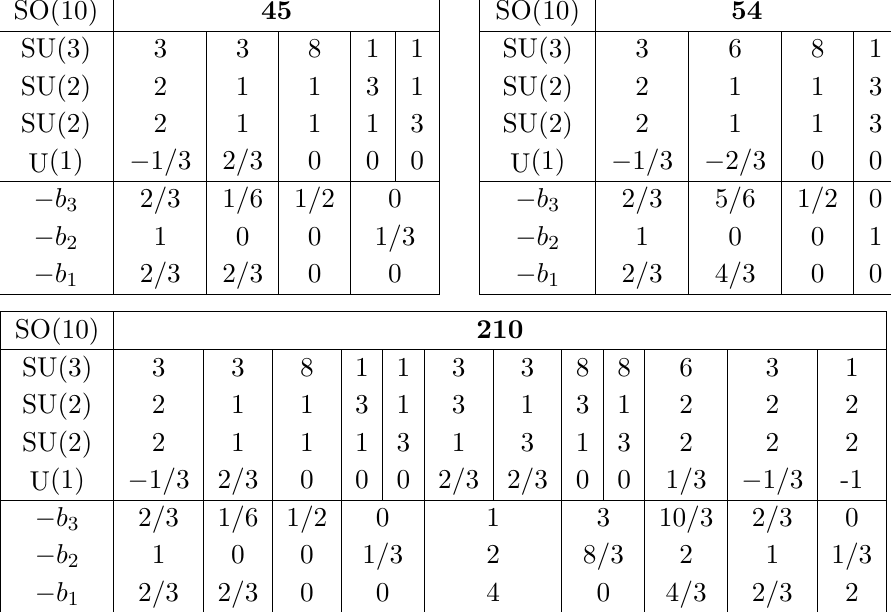
Table 3 . Decomposition of 45 , 54 and 210 into representations of 3221. For complex representa- tions, complex conjugations of them are understood.